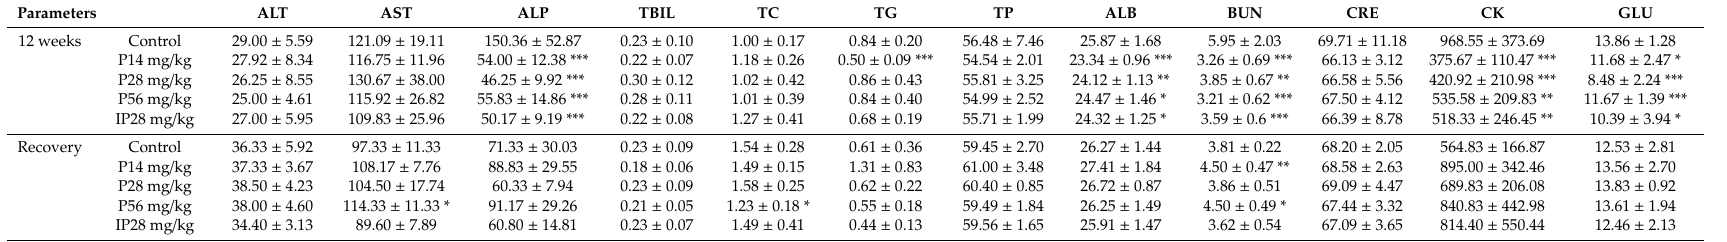
Table 2. The blood biochemical parameters of rats after 3 months of repeated administration and 2 weeks of recovery, respectively (mean ± SD, n = 12 for administration and n = 6 for